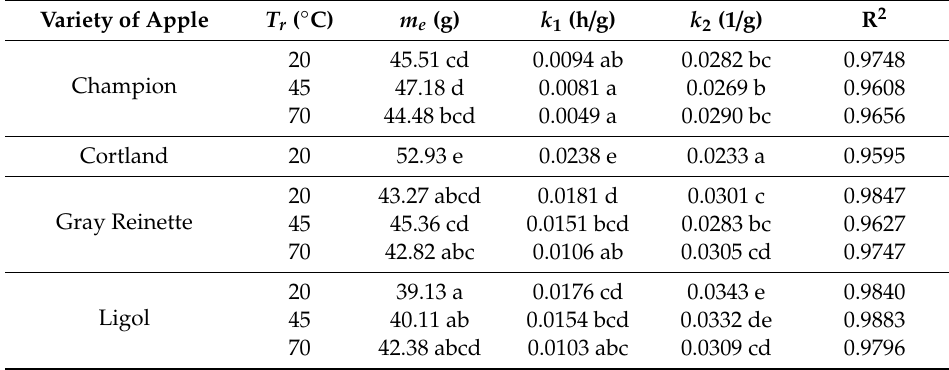
Table 2. Results of the application of the Peleg model (Equations (8) and (9)) for approximating the mass gain during the rehydration of di ff erent varieties of dried apples.